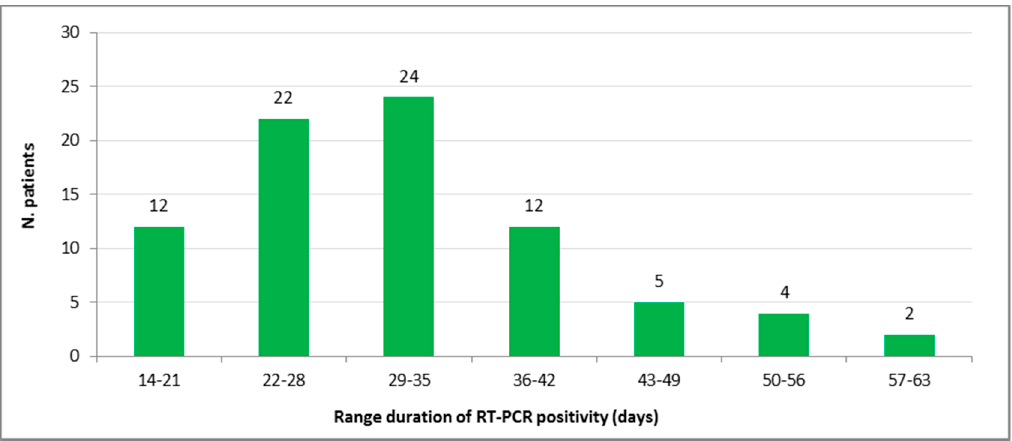
Figure 4. Number of patients distributed according to the range duration of qPCR positivity (Min = 14; Max = 63).